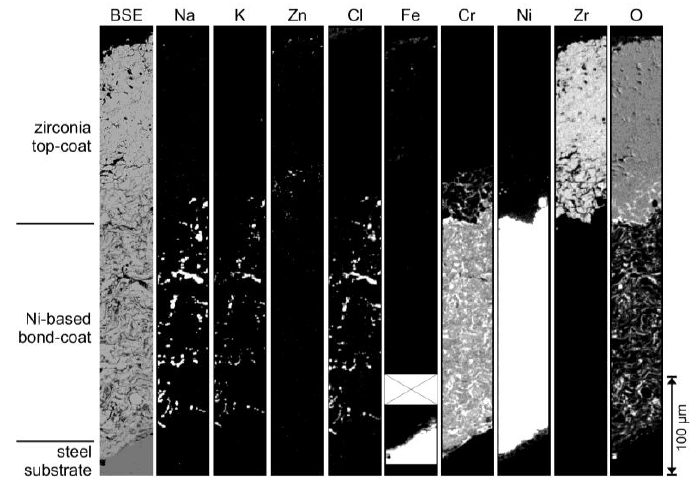
Figure 4. Back-scattered electron (BSE) image in combination with element mappings of sodium, potassium, zinc, chlorine, iron, chromium, nickel, zirconium, and oxygen of the multilayer coating from the lee-side of the uncooled test probe (TP 1—700 °C for 14 days). The element mapping of Fe is separated into two parts with different scales in order to visualize the distribution of different amounts within the coating: upper part—low amount (25–250 cts); lower part—high amount (400–1200 cts) of Fe.